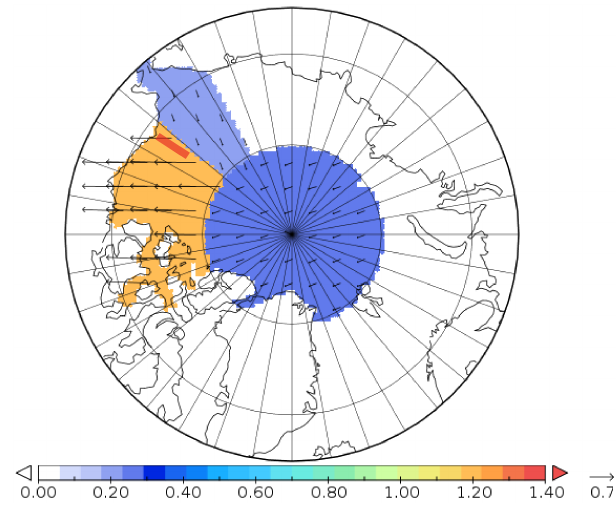
Figure 11. Wind stress direction with highest impact of tau compo- nent in control vector on ice thickness in NOB target region (dark red colour). Colour indicates